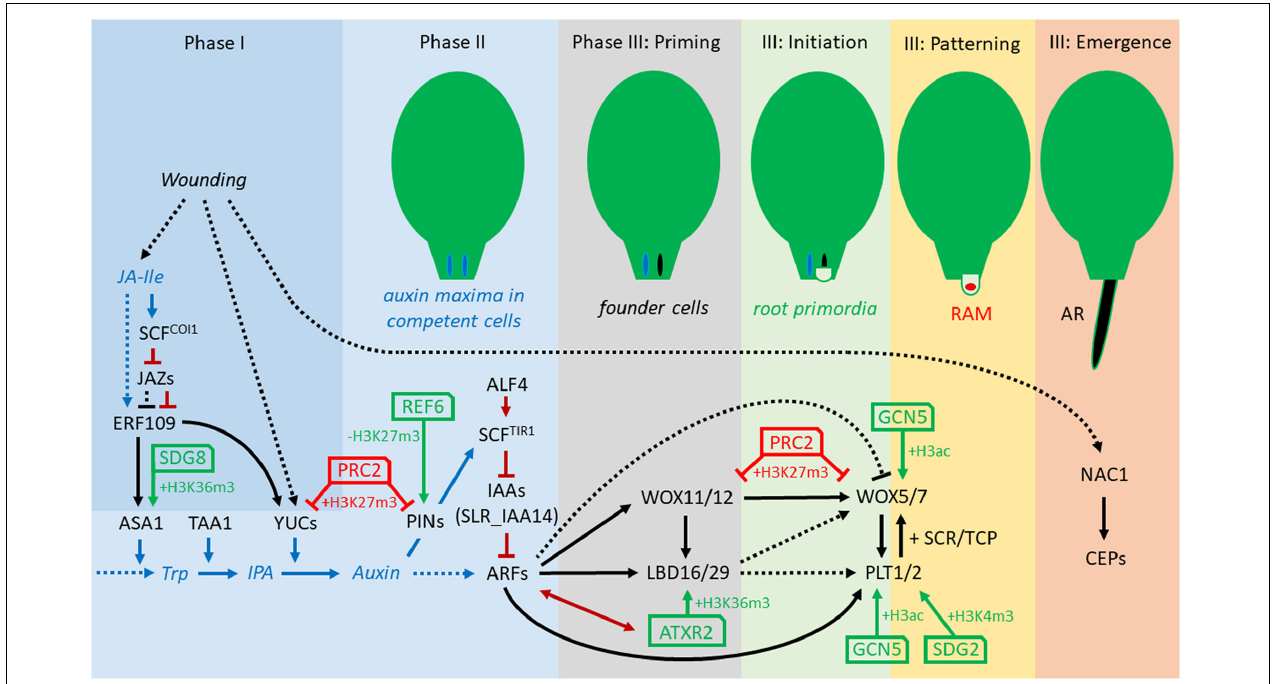
FIGURE 1 | Concept of transcriptional and epigenetic regulation network during direct excision-induced DNRR in Arabidopsis . The three phases and four stages of phase III, priming, initiation, pattering, and emergence, are according to Yu et al. (2017) and Xu (2018). Note that several relations are not yet verified for DNRR but demonstrated for callus formation, LR initiation and/or regular root development. Black arrows, direct transcriptional regulation; dotted arrows, indirect regulation; blue arrows, JA and auxin synthesis and transport; dark-red arrows, protein-protein interaction; green arrows, positive epigenetic regulation; red arrows, negative epigenetic regulation. ALF4, ABERRANT LATERAL ROOT FORMATION4; ARFs, AUXIN RESPONSE FACTORs; ASA1, ANTHRANILATE SYNTHASE α 1; ATXR2, ARABIDOPSIS THALIANA TRITHORAX-RELATED2; CEP, Cys endopeptidase; ERF109, ETHYLENE RESPONSE FACTOR109; GCN5, GENERAL